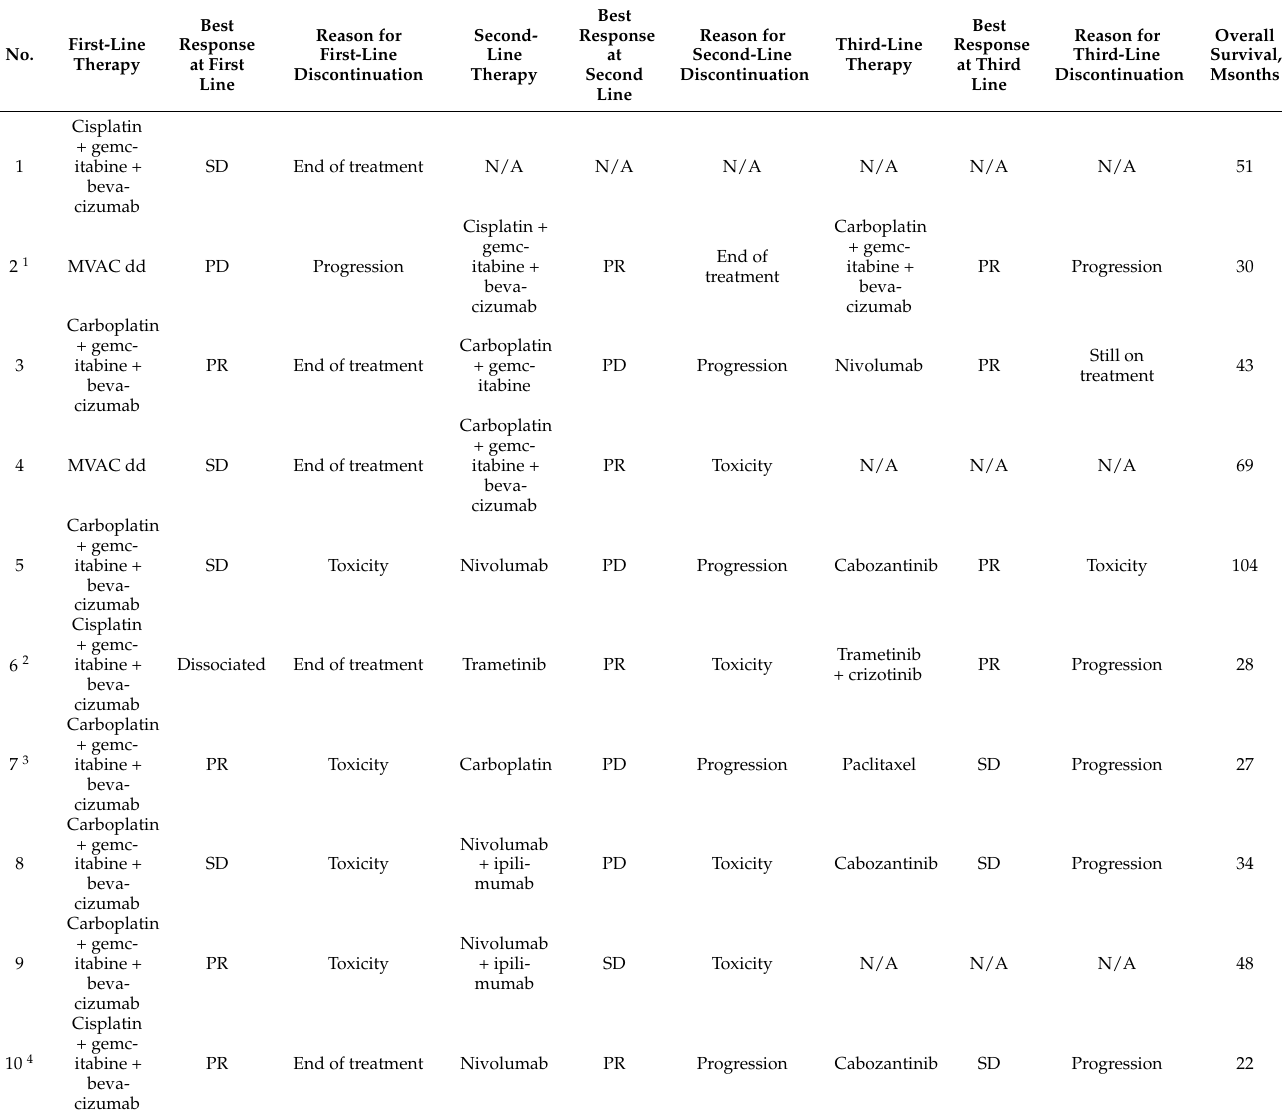
Table 4. Characteristics of patients who achieved an objective response after subsequent-line therapy or were long-term